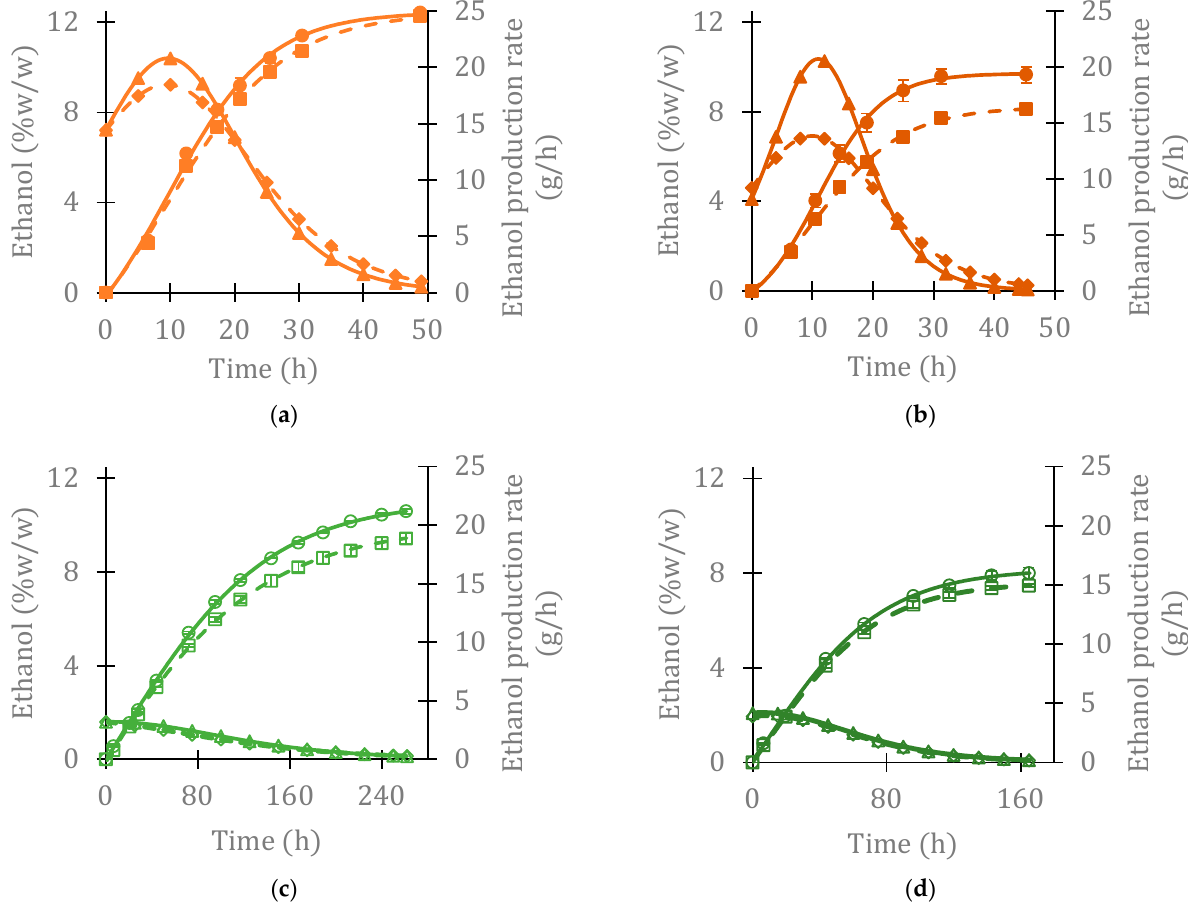
Figure 4. Ethanol concentration and production rate during each fermentation configuration: ( a ) LTHF (orange); ( b ) HTHF (dark orange); ( c ) LTLF (green); ( d ) HTLF (dark green). Fermentations were performed in duplicate. Models were obtained using a Logistic 4P model with a 95% confi- dence interval. The error bars represent the standard deviation of the data. The data shown repre- sent ethanol concentration data under vacuum (circles) and atmospheric pressure (squares); ethanol concentration model under vacuum (continuous lines) and atmospheric pressure (dotted lines); eth- anol production rate under vacuum (up-pointing triangles and continuous lines) and atmospheric pressure (diamonds and dotted lines).